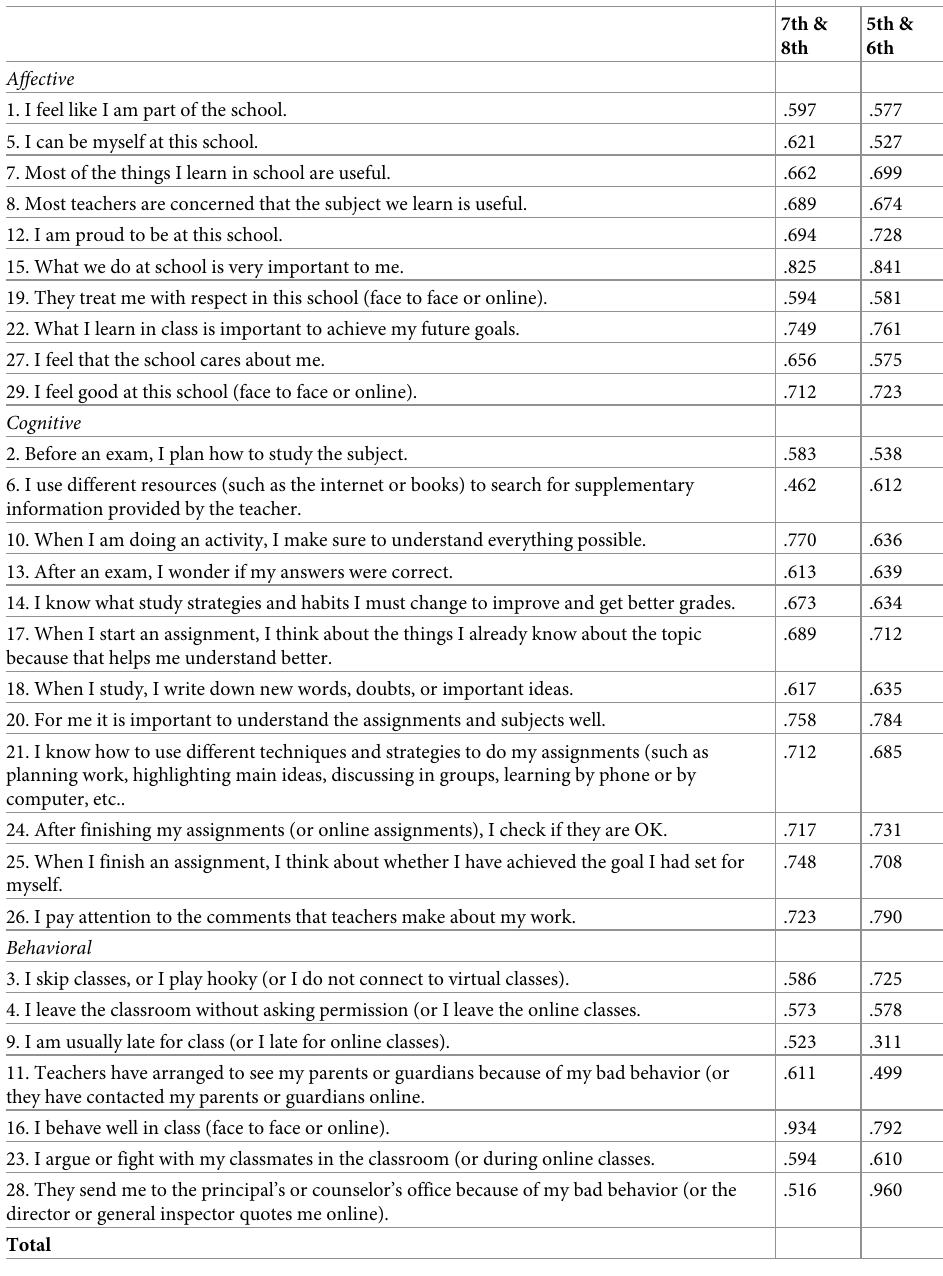
Table 1. Items content and factor loadings of the school engagement questionnaire. Factors and